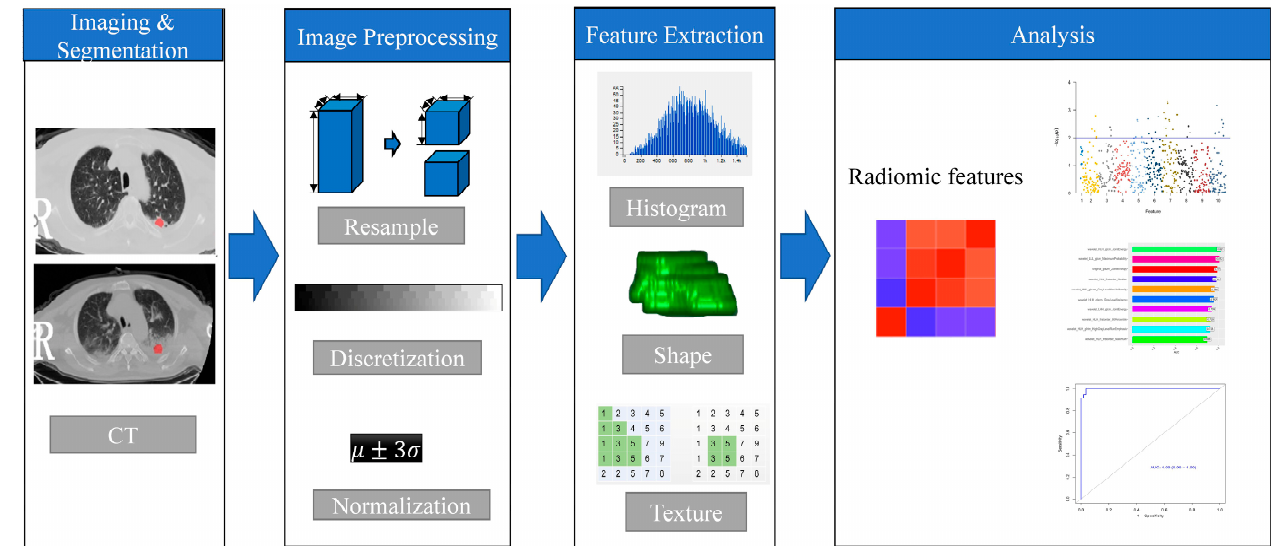
Figure 1. Workflow of the radiomics method. An experienced radiologist segmented the region of interest (ROI) of the lesions. Features were selected to build models. The receiver operating characteristic (ROC) was used to demonstrate diagnostic efficiency of the models.